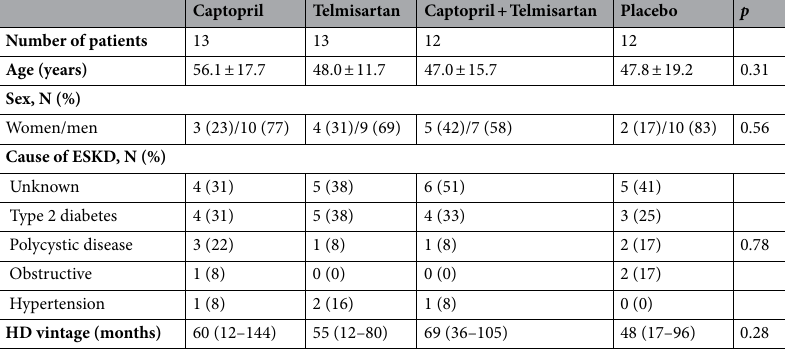
Table 1. Comparison of baseline demographic characteristics between groups. ESKD end-stage kidney disease, HD